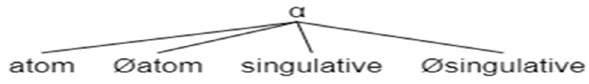
Figure 4. Geometry of the ON α.